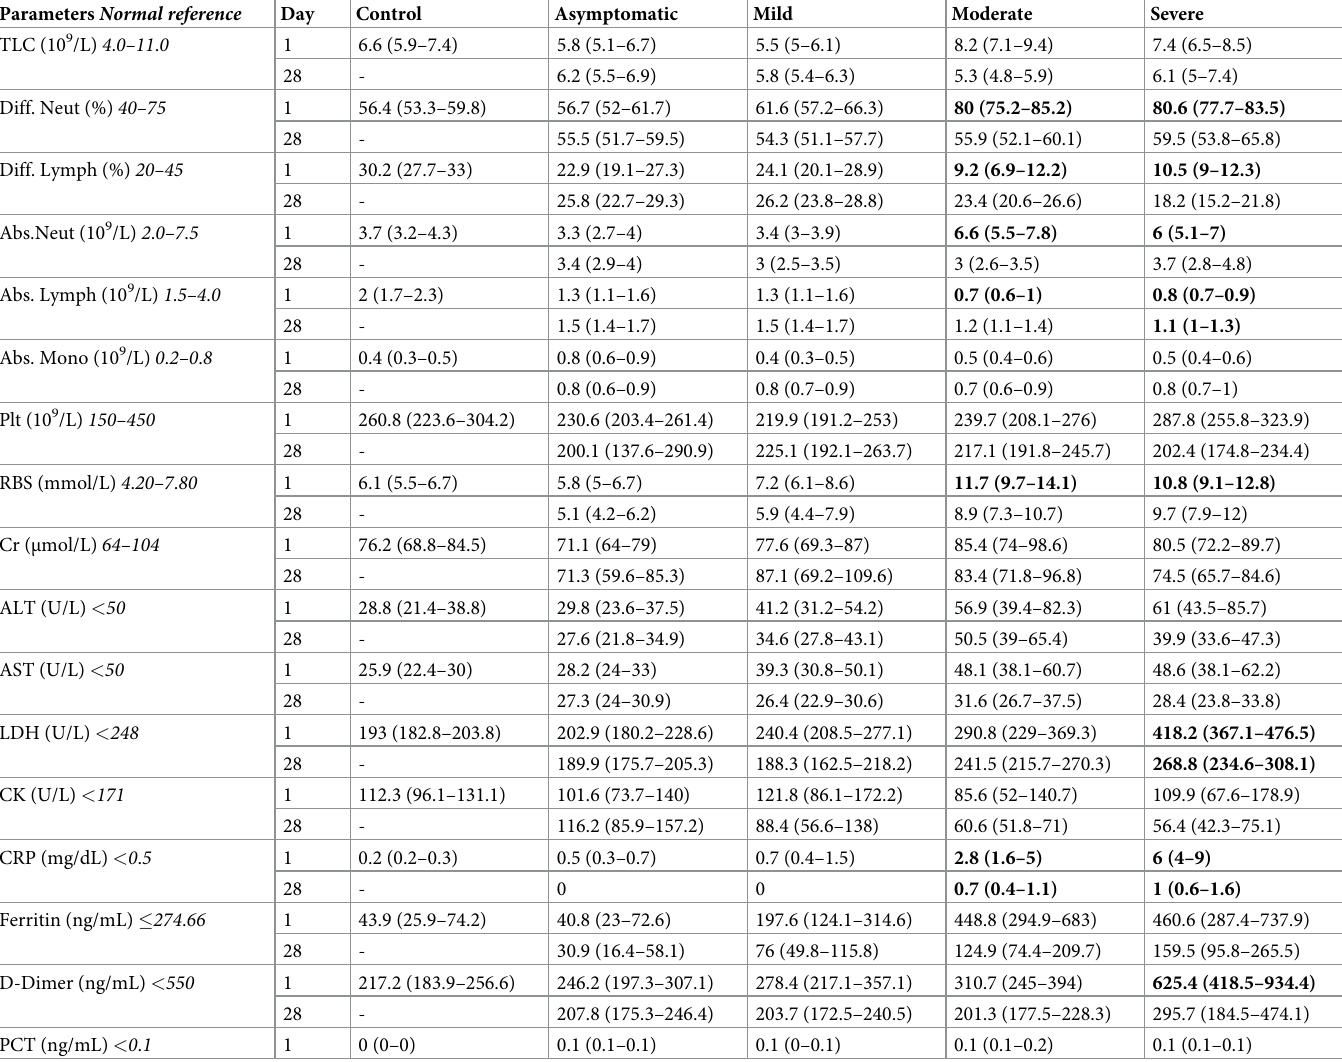
Table 4. Laboratory parameters in COVID-19 patients with differing